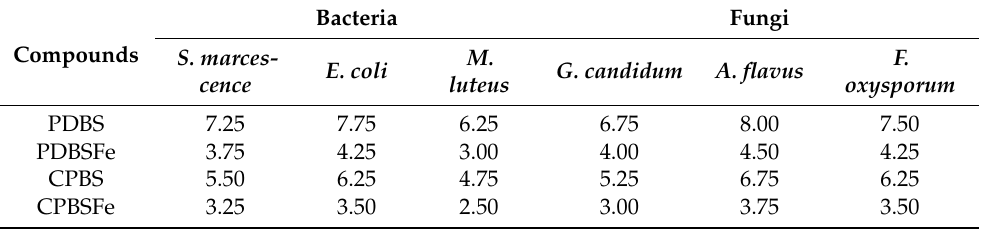
Table 6. Antimicrobial assay minimum inhibition zone (MIC) of the prepared PDBS and CPBS imine ligands and their Fe 3+ chelates. Bacteria Compounds